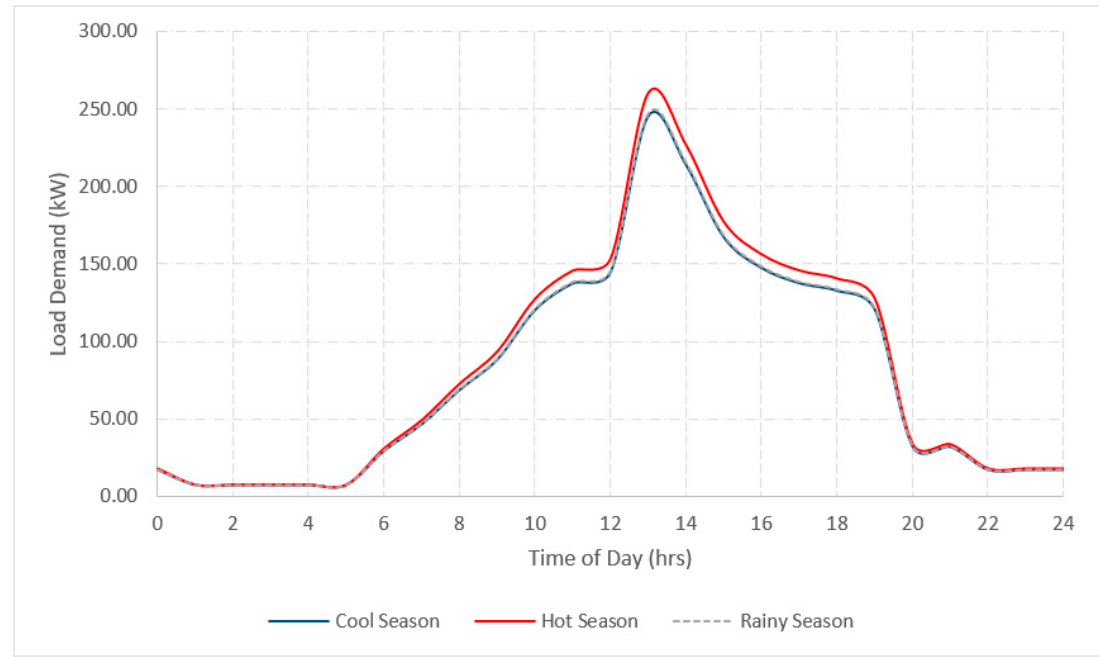
Figure 5. Averaged synthetic daily load profiles for urban Yangon city.